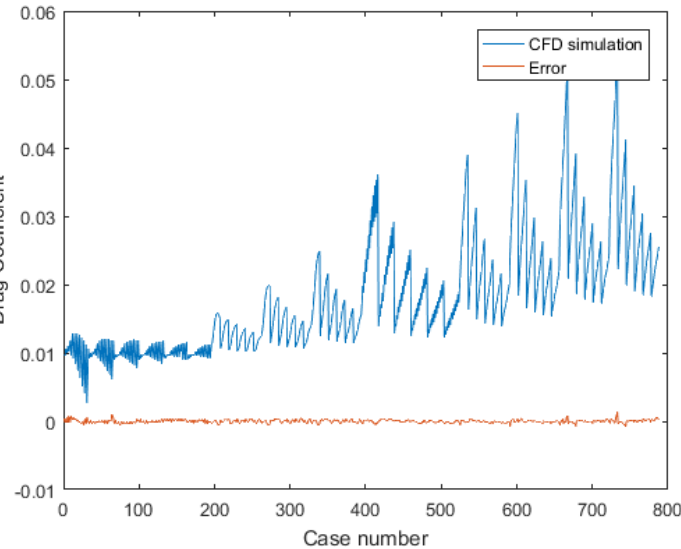
Figure 8. Comparison between the prediction from trained ANN and the CFD simulation